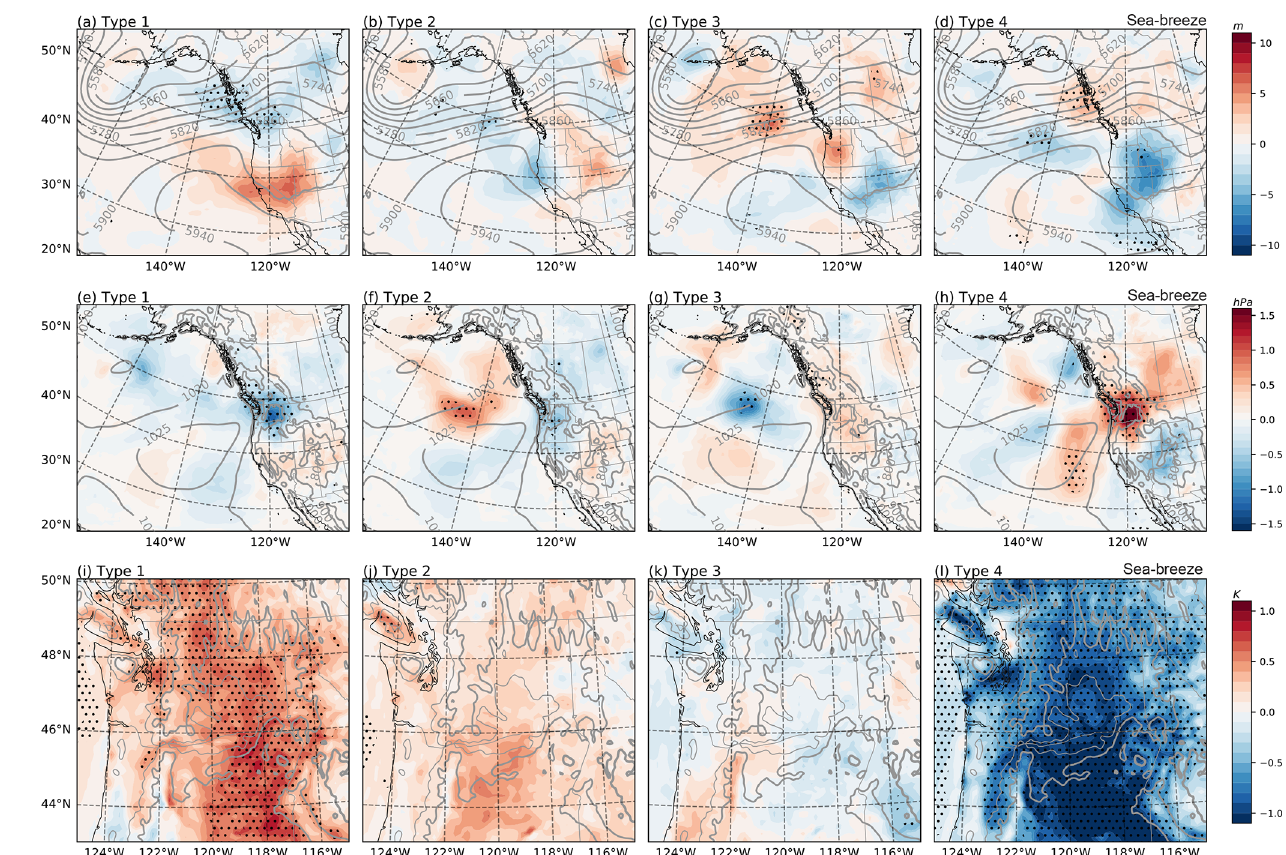
Figure 6. (a–d) 500hPa geopotential height, (e–h) surface pressure, and (i–l) 2m temperature anomaly for each SOM type from ensemble average for the sea-breeze case at 6h. Contours in panels (a) – (h) indicate the ensemble average. Gray lines in panels (i) – (l) indicate terrain elevation of 500 (thin) and 1000m (thick). The dots indicate the differences are significant at the level of 0.05.